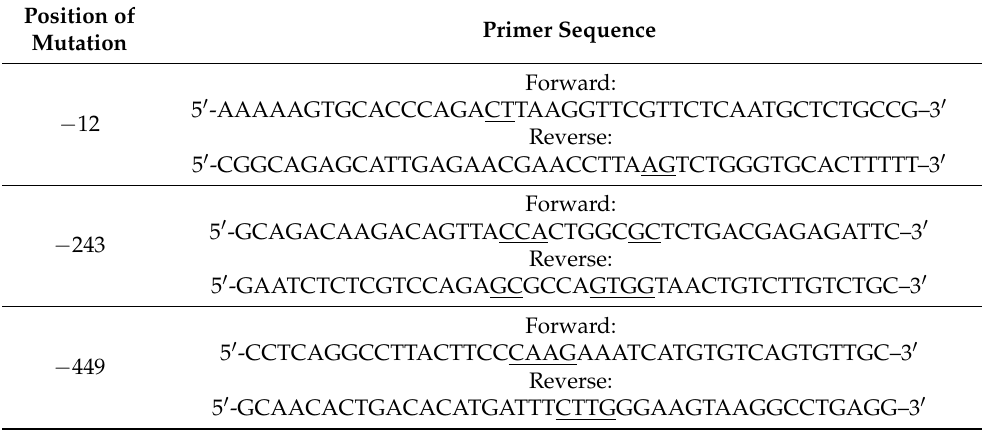
Table 2. Primers used in GATA site mutagenesis. The positions of mutations are underlined. Position of